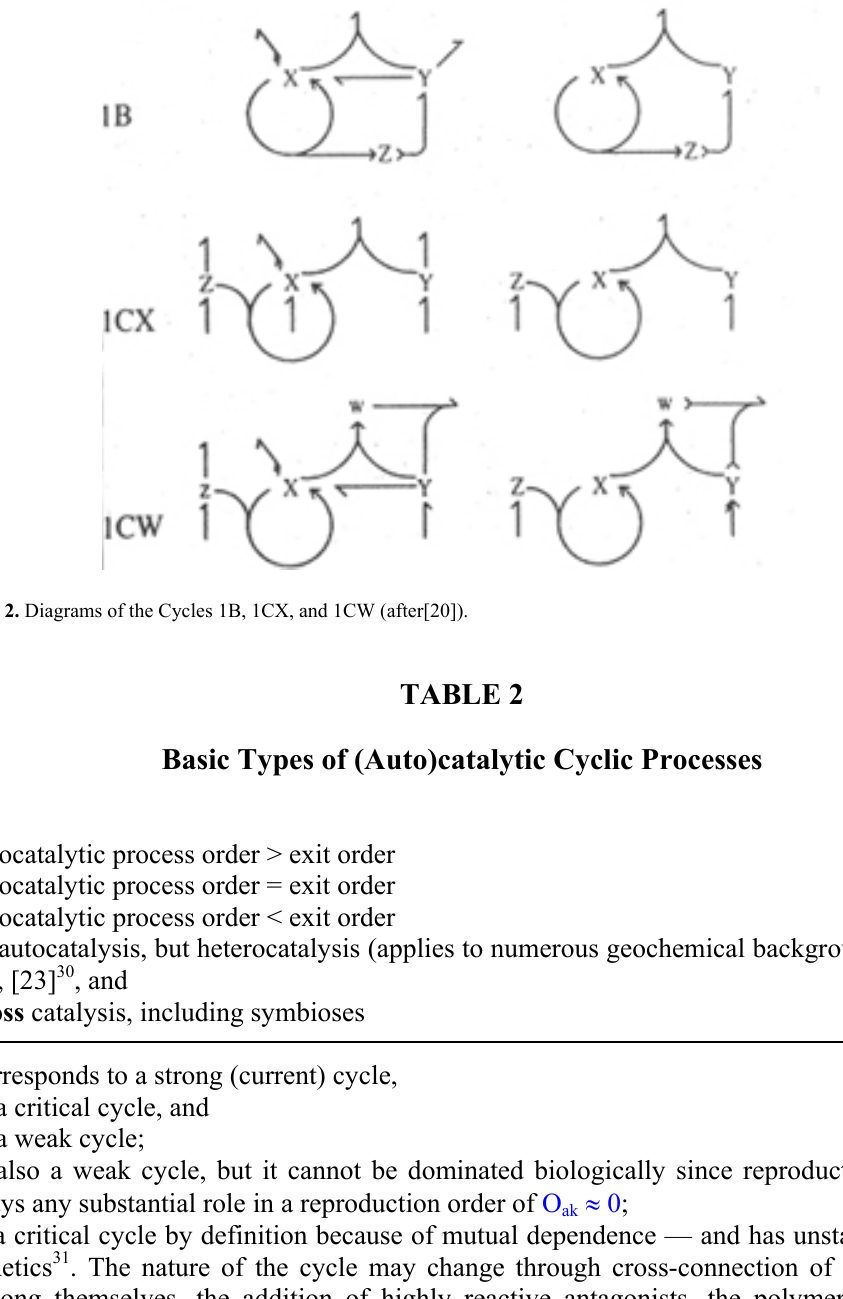
Basic Types of (Auto)catalytic Cyclic